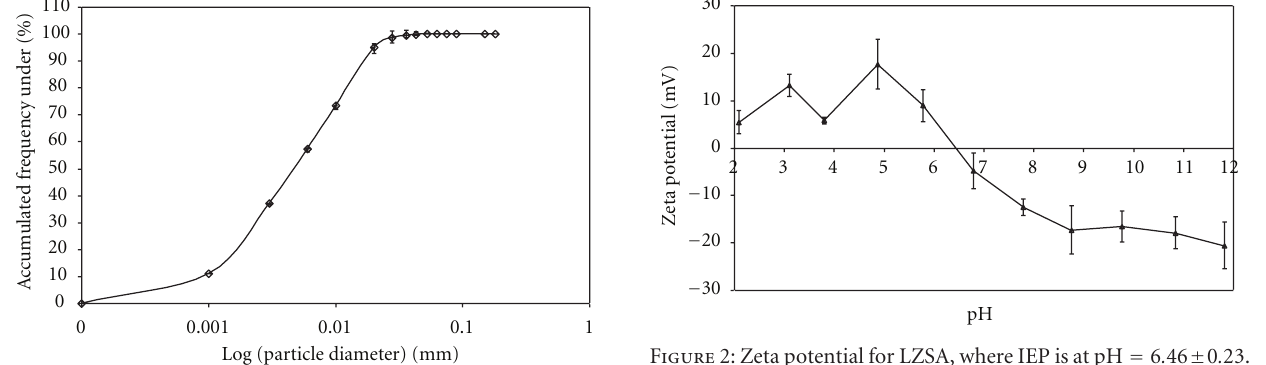
Figure 1: Particle size analysis of LZSA powder after ball milling for 144h.